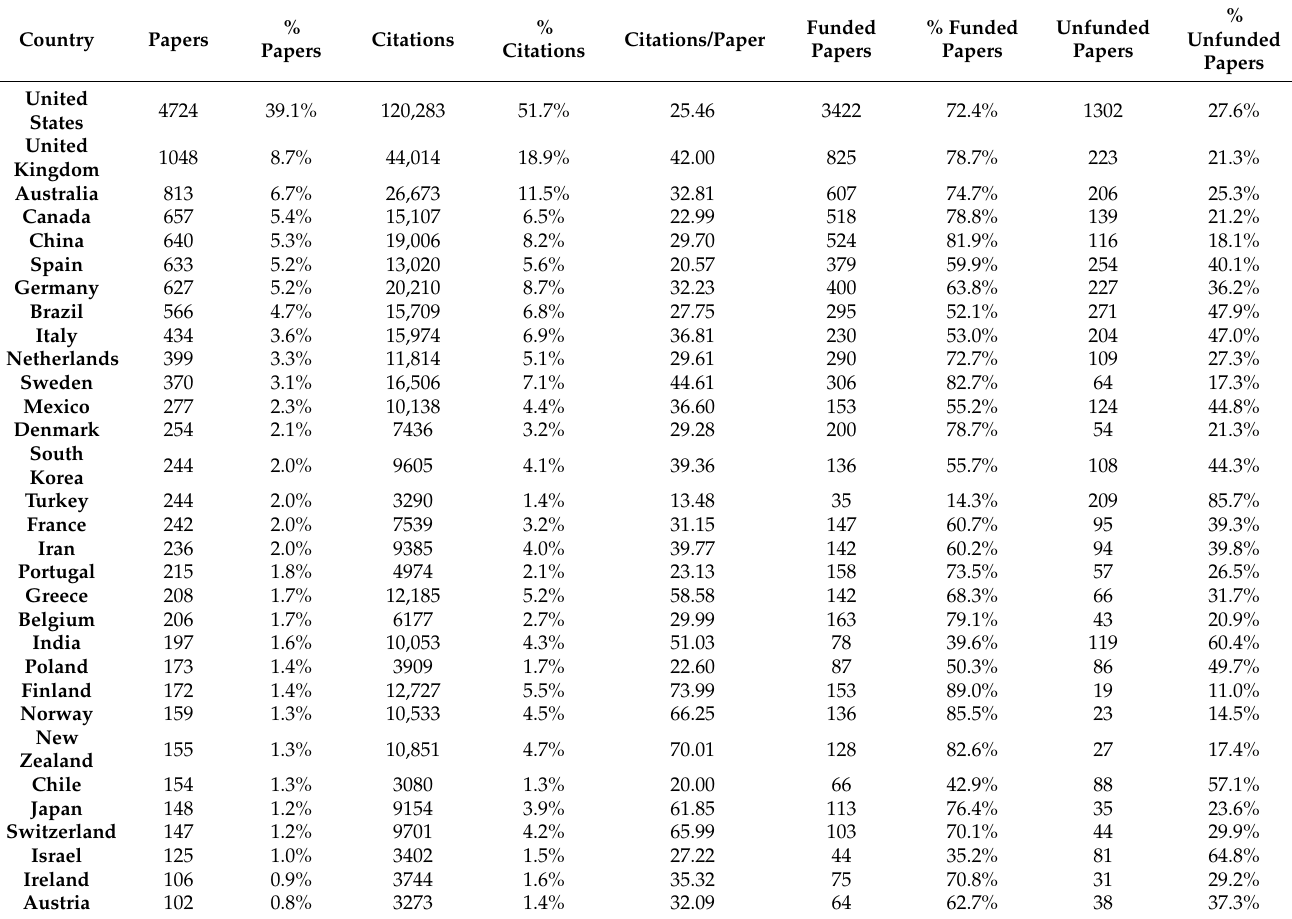
Table 4. Most productive countries, citations, and citations per